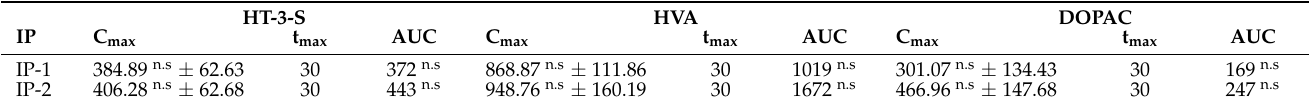
Table 4. Pharmacokinetic parameters from plasma concentration. C max : peak plasma concentrations expressed in nmol/L ± SEM; t max : time (in minutes) to reach C max ; AUC: mean area under the plasma concentration time curve from 0 h to 12 h. Plasma concentrations at baseline (t0) were below the LOQ. n.s: no significant difference between